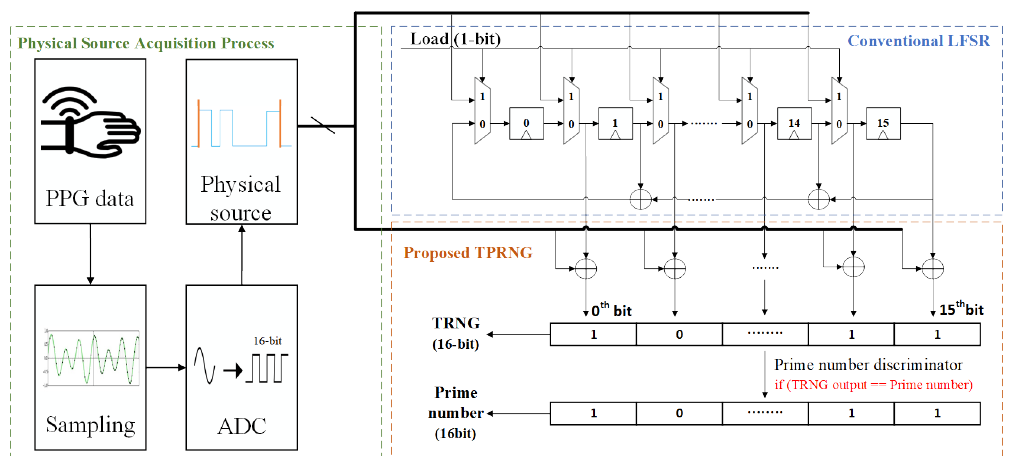
Figure 1. Conventional LFSR random number pattern.